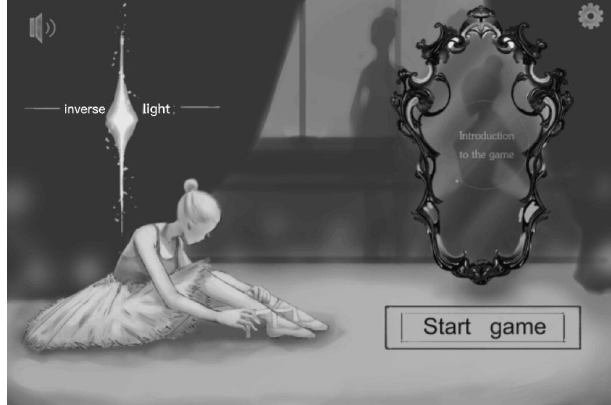
Figure 5. The in-game